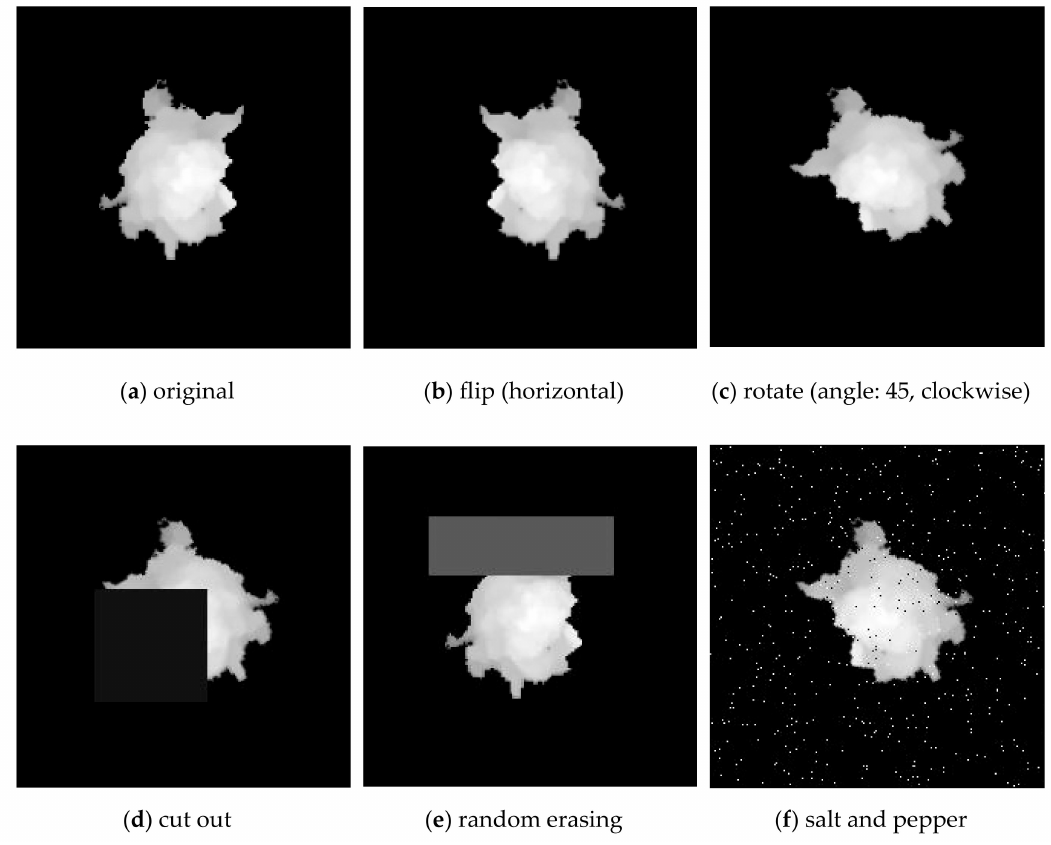
Figure 11. Augmented crown images. The pixel value of each image is normalized from zero to one using minimum and maximum pixel value of each image. The size of each image is 224 × 224 pixels. Cut out randomly selects a square region in an image and erases its pixels with the mean value of the image. Random Erasing randomly selects a rectangle region in an image and erases its pixels using random values. Salt and pepper refers to the addition of white and black dots in the